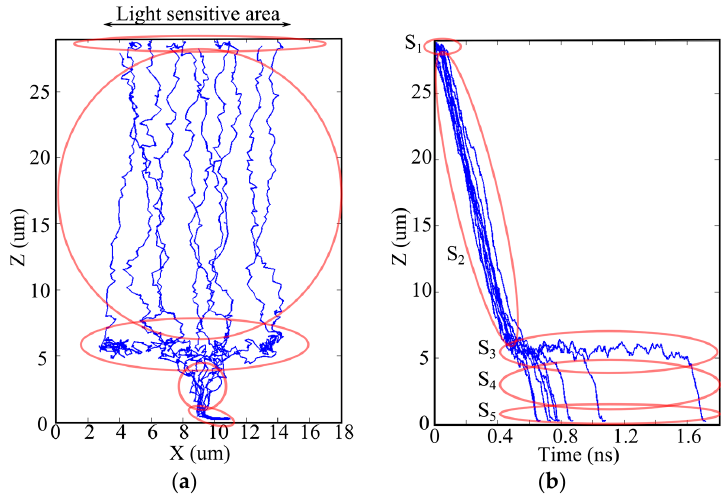
Figure 3. Monte Carlo simulation of trajectories of signal electrons and segments of the trajectories. ( a ) Trajectories; ( b ) travel time versus travel distance from the collection gate. S1: Motion in the backside hole accumulation layer; S2: Motion in the depleted bulk silicon layer; S3: Motion over the p-well; S4: Motion in a p-well hole; S5: Motion to a collection gate.